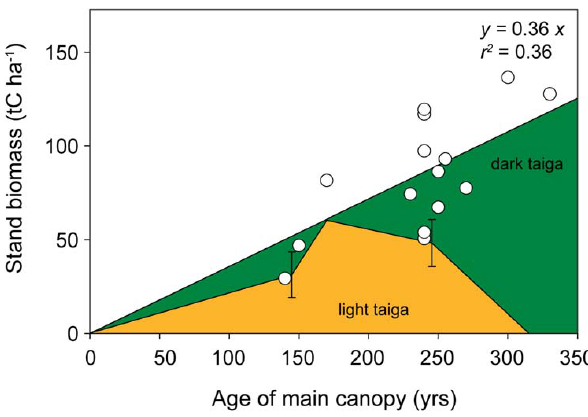
Fig. 8 Fig. 8. Stem volume per unit area as related to stand age. The shaded area indicates the proportion of light and dark taiga species on total stem biomass. Dark taiga species may also contribute a sig- nificant fraction in young stands until the first surface fire eradicates these individuals. Only a next generation can become dominant, if there is no further